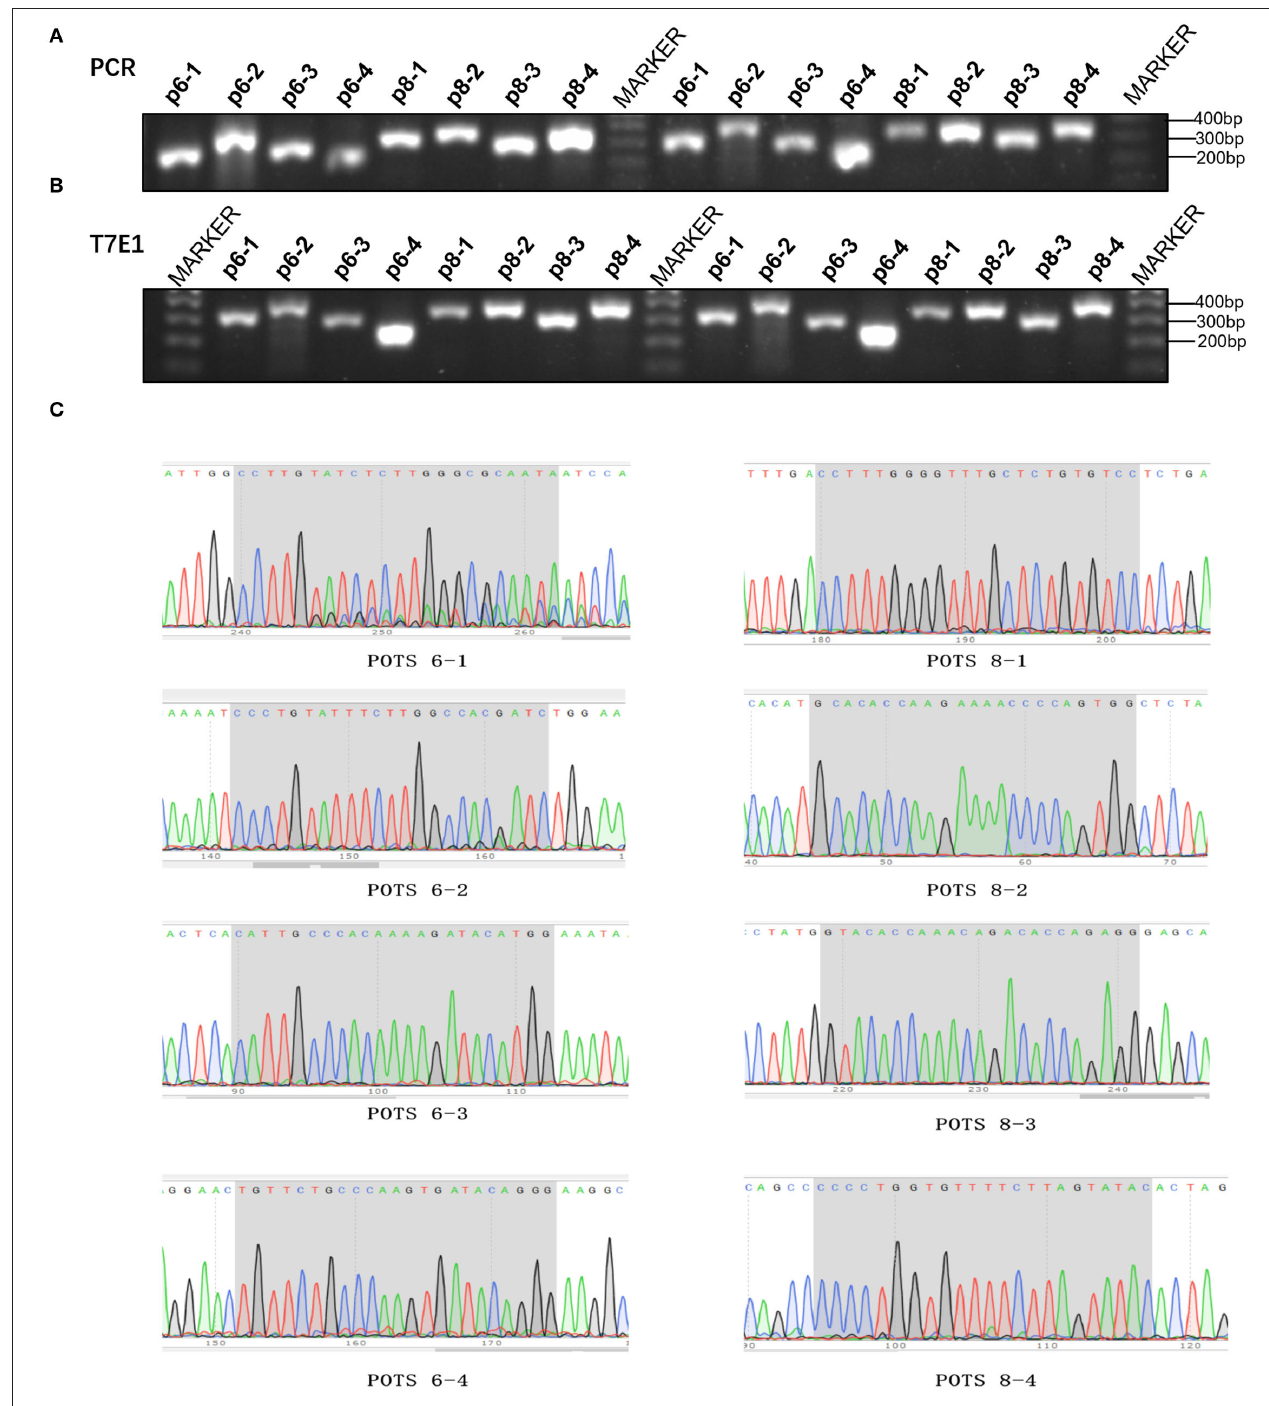
FIGURE 5 | Detection of MSTN modified rabbits. (A) The results of suspicious POTs in Agarose gel electrophoresis of PCR products. M: DL100bp; p6-1–p6-4 represent g6 four suspicious POTs, p8-1–p8-4 represent g8 four suspicious POTs (The picture has been cropped). (B) The results of suspicious POTs in Agarose gel electrophoresis of T7E1. (C) Sanger sequencing for suspicious POTs